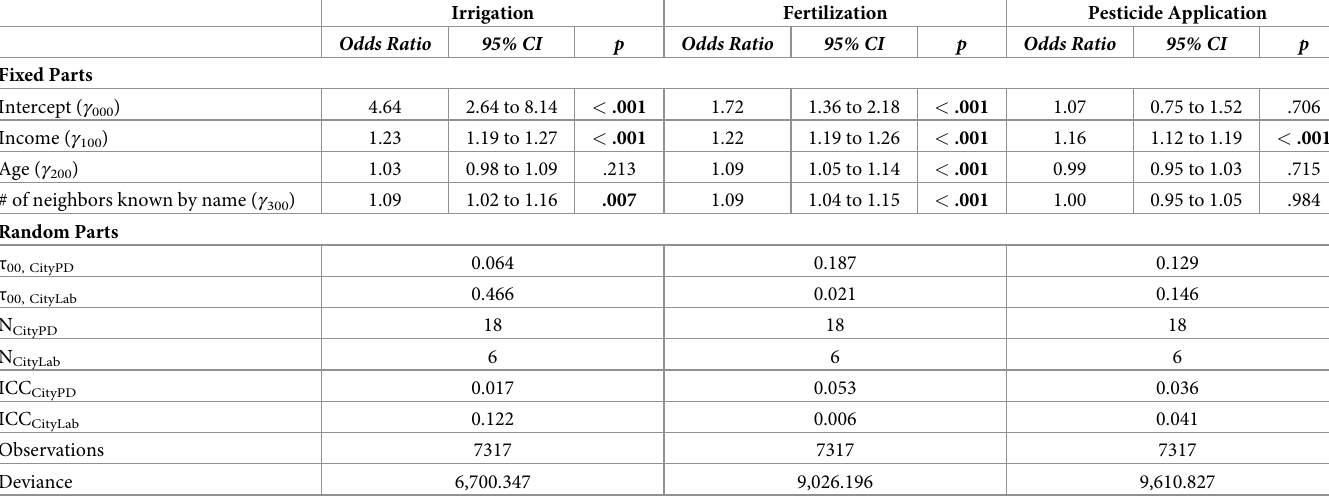
Table 3. Three-level binary logistic regression outputs for irrigation, fertilization, and pesticide